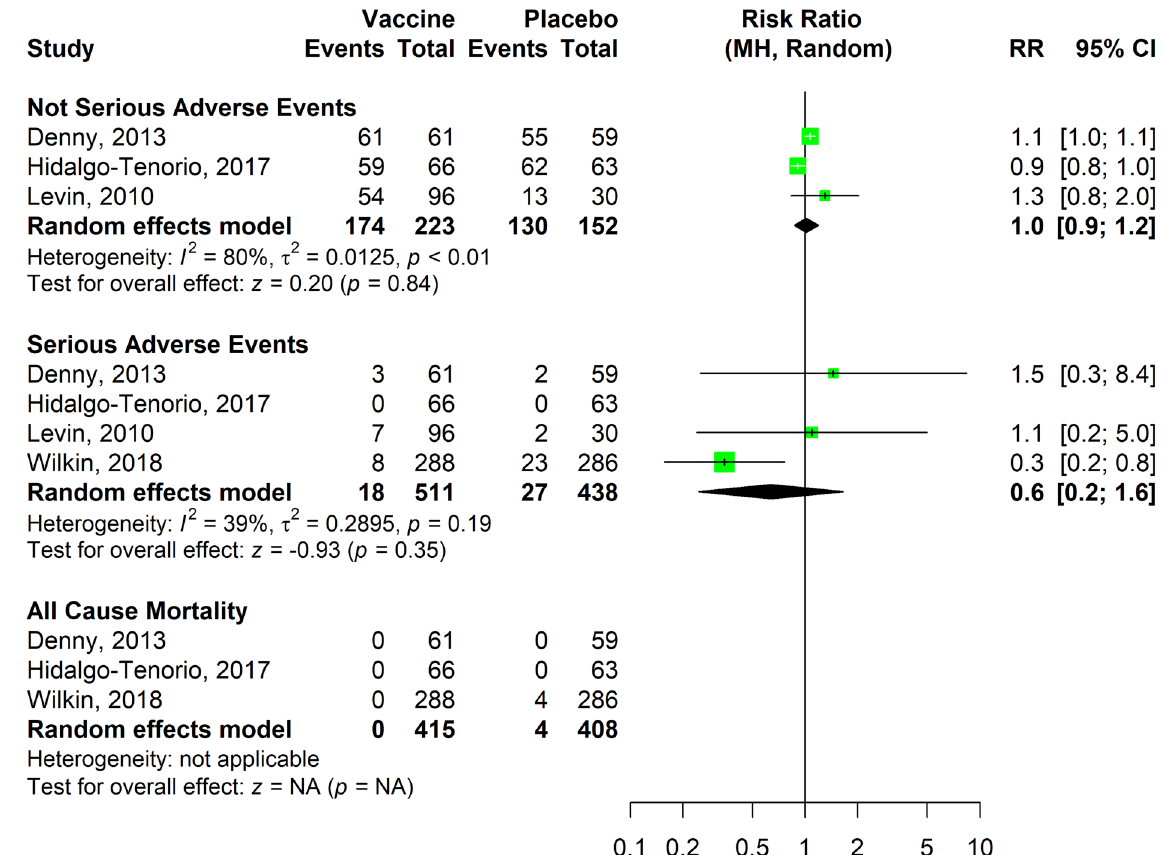
Figure 4. Data synthesis for seroconversion outcome